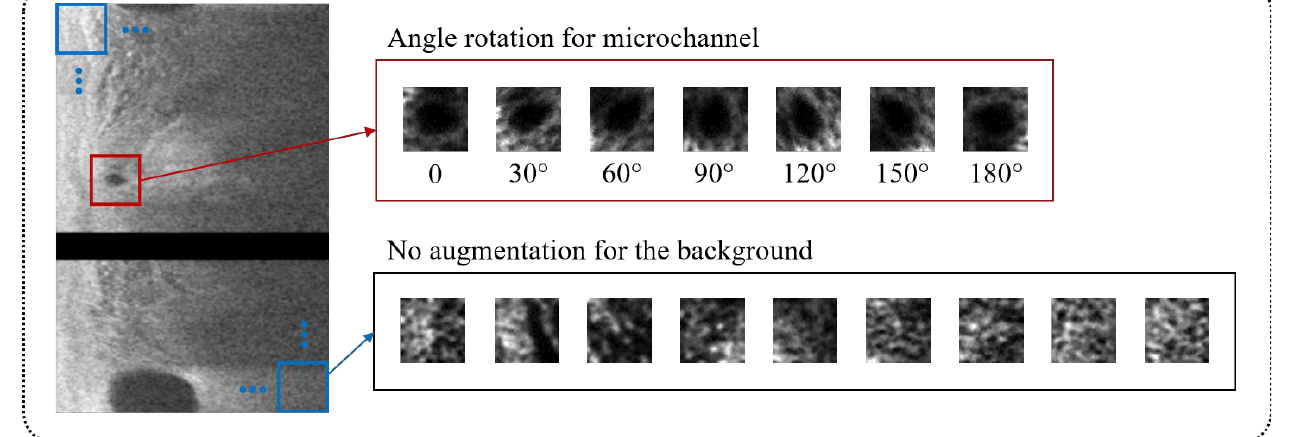
Figure 3. Data augmentation for candidate classification network. The bounding boxes with mi- crovessel (red) were augmented by rotating its angle from 30° to 180° with a 30° interval, providing a seven times greater number of microvessel cases. The bounding boxes without microvessel (blue) were not augmented.